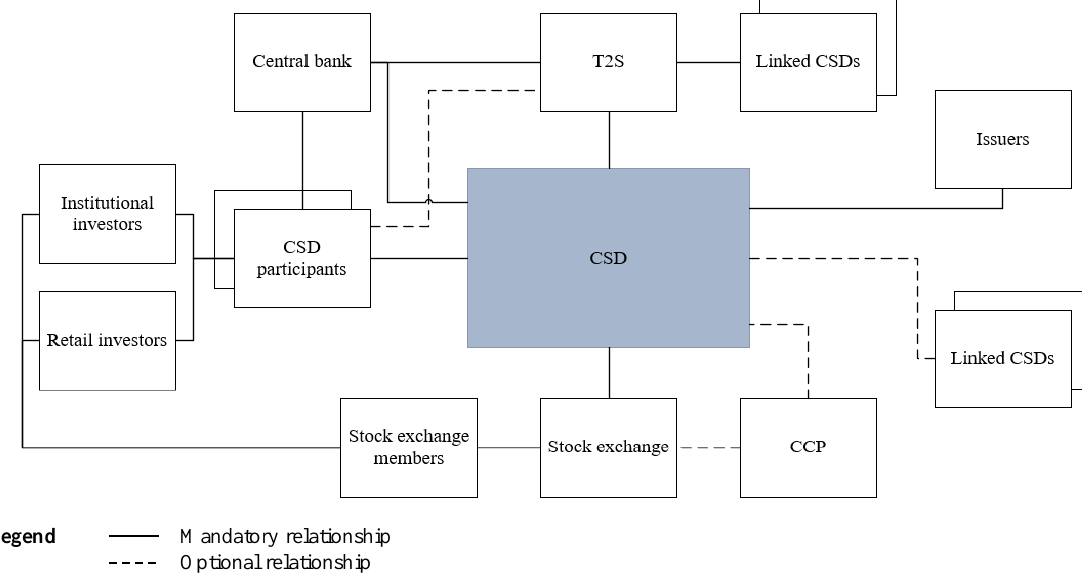
Figure 1. Financial market components and relations (available also in